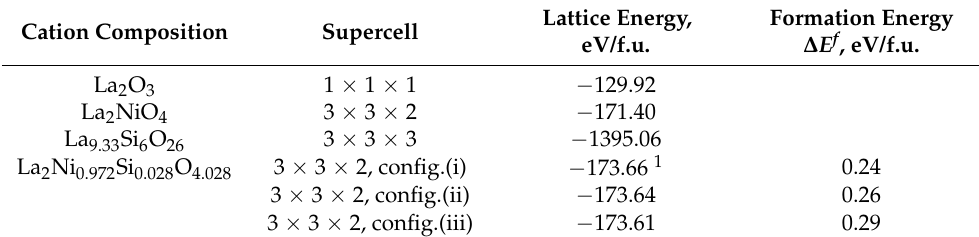
Table 3. Simulated supercells and calculated lattice energies per formula unit. Cation Composition Supercell